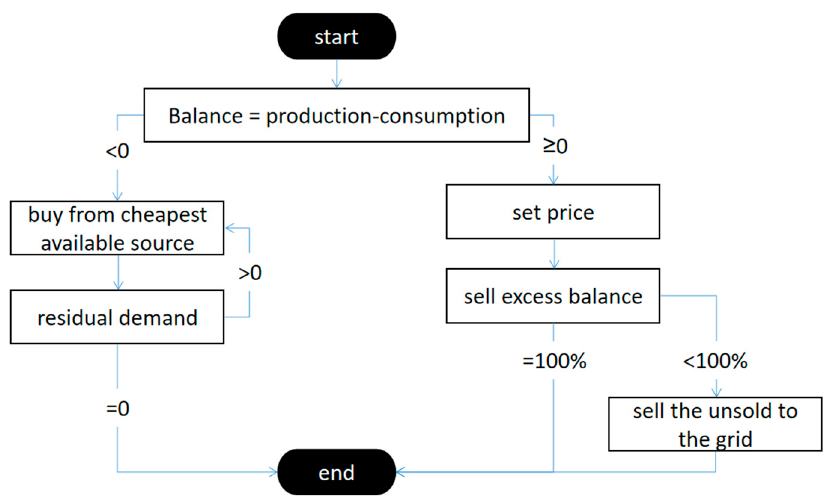
Table 1. PV capacities per household and prices in the 6 different scenarios.